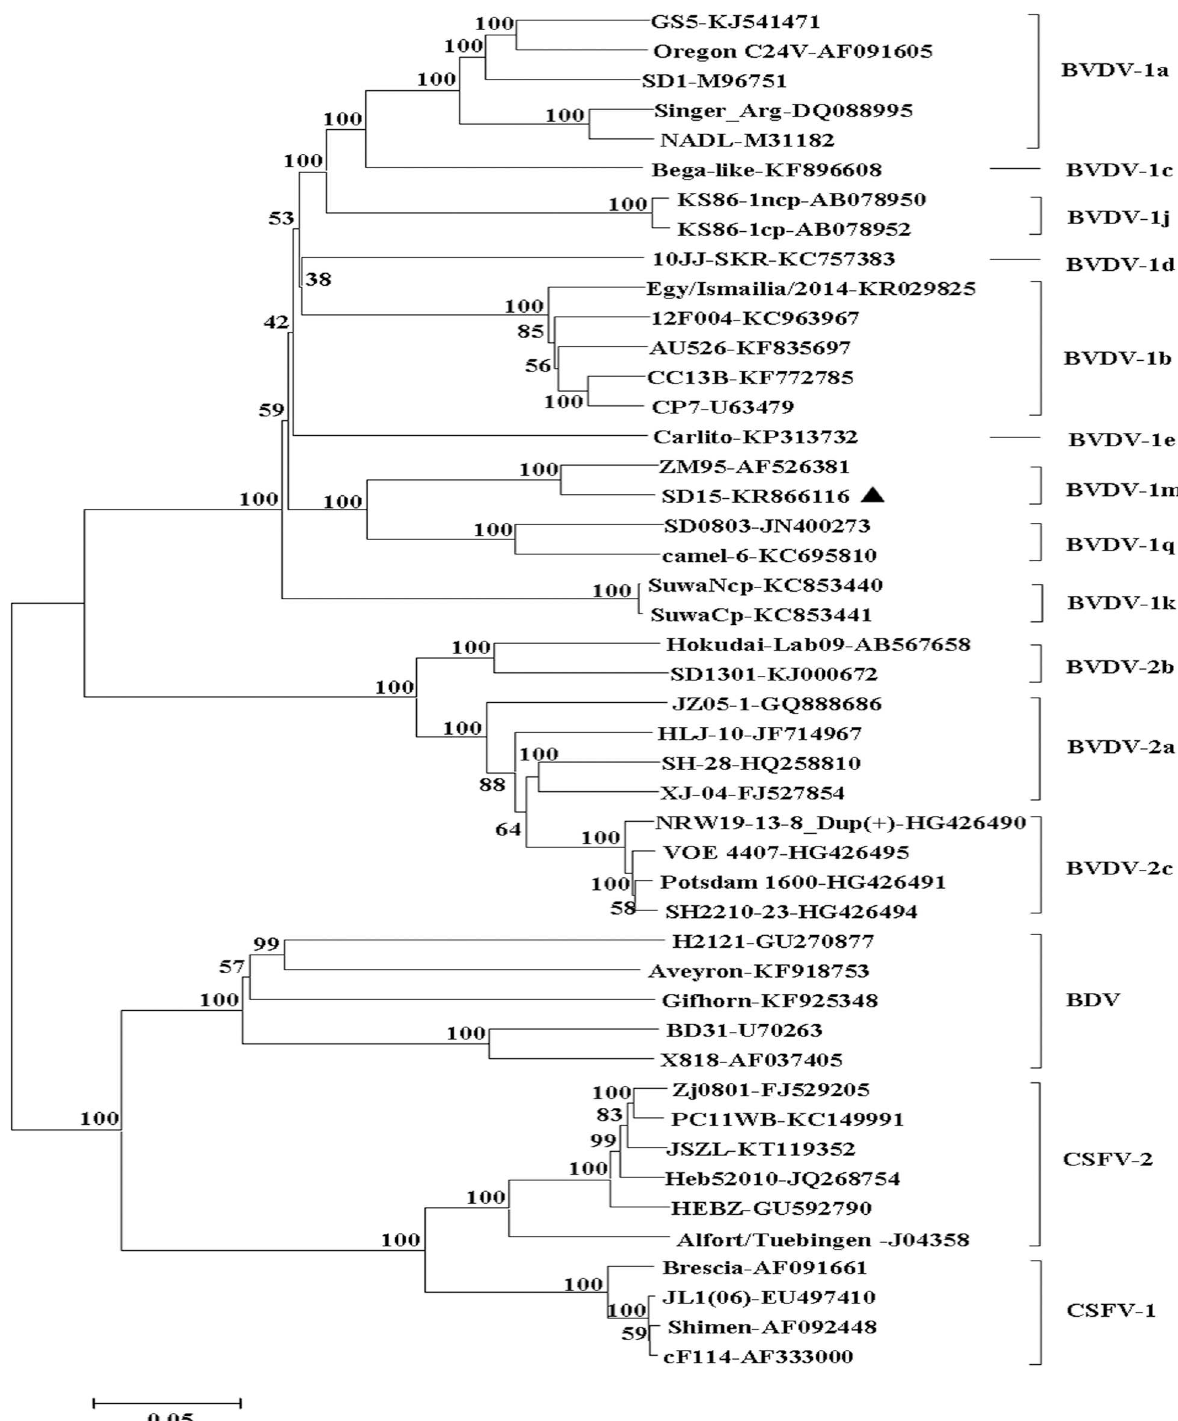
Fig 3. Phylogenetic analysis of SD-15 with pestiviruses based on the complete genomic sequences. The complete genome sequenceof SD-15 was alignedwith representative pestivirusesand phylogenetic tree was generated using the neighboring-joining methods by MEGA 5.2 software. Four major clusters includingCSFV, BDV, BVDV-2 and BVDV-1 with different subgenotypes were formed and indicated,respectively. SD-15 together with ZM-95 was groupedin BVDV-1m subgenotype.